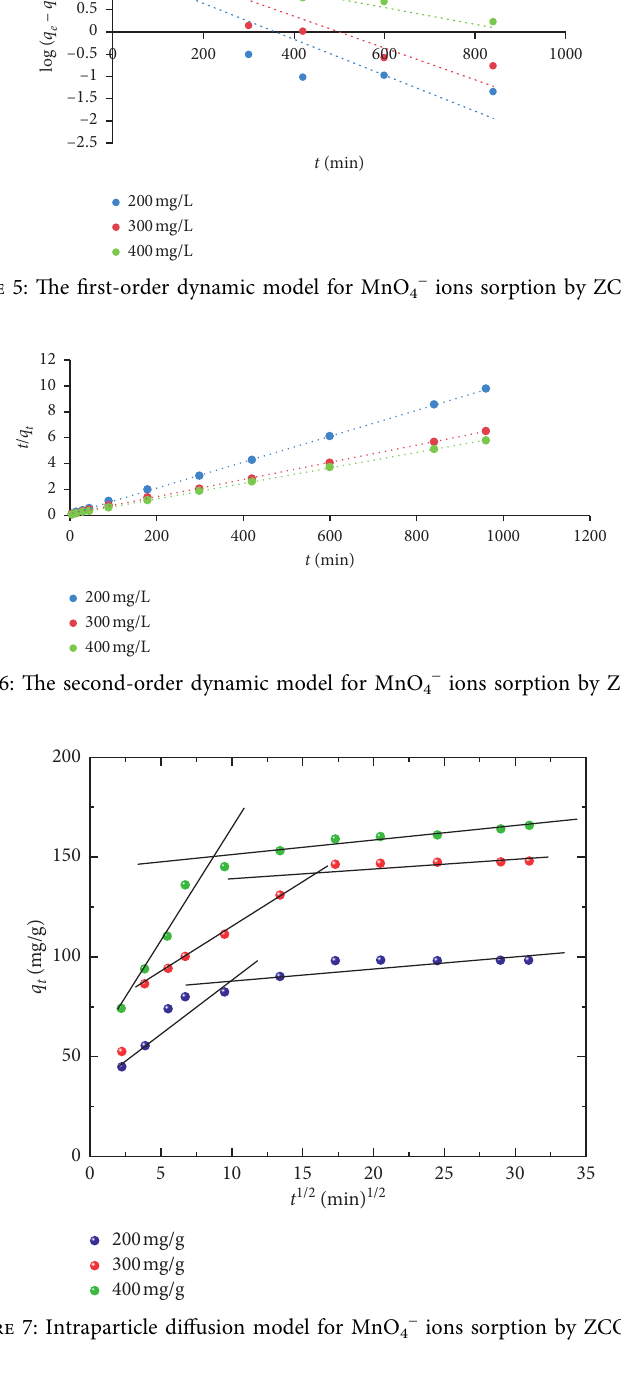
Figure 7: Intraparticle diffusion model for MnO Table 3: Parameters of the 1st- and 2nd-order dynamic models for MnO C 0 (mg/L) q e , exp